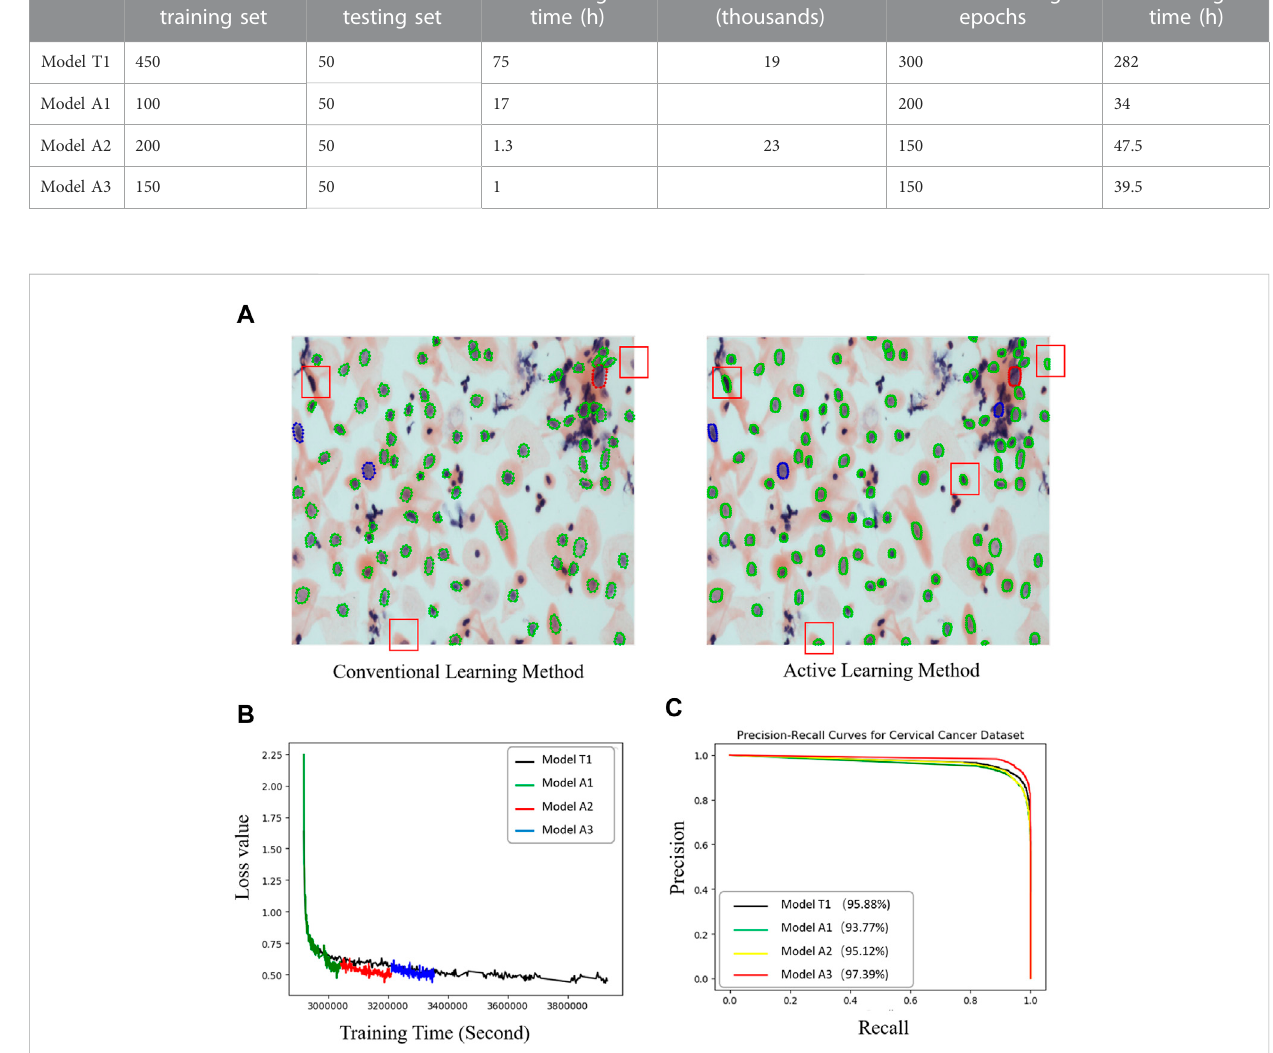
FIGURE 2 Performance comparisons between the active and conventional learning methods. (A) Comparison of nucleus segmentation results between manual annotation and active learning methods. Red and light blue boxes: nuclei missed in the manual annotation method. Orange boxes: nucleus with bettercontoursegmentationbytheactive learningmethod compared to thetraditionalmanual labeling method. (B) Losscurves oftwomethods (model T1:conventionalmethod;A1,A2,andA3:activelearningmethod)showingthefasterregressionfortheactivemethod. (C) PRcurvesofallmodelsfor cervical cell image recognition. The percentages in the legend are the prediction accuracies of the models.